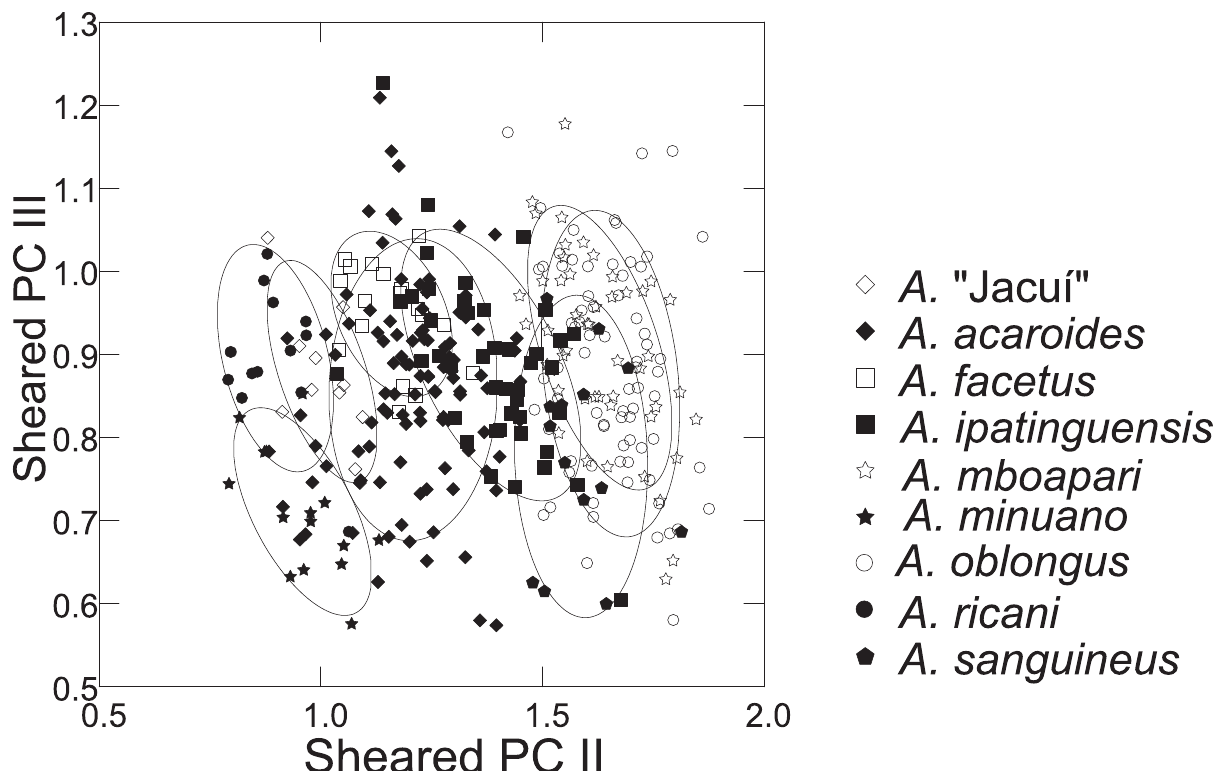
Fig 4. Plot of specimen scores of PC II on PC III from PCA of 15 distance measurements from pooled coastal species of Australoheros , and A . “Jacuı´.” (Table S4.1 in S4 File).